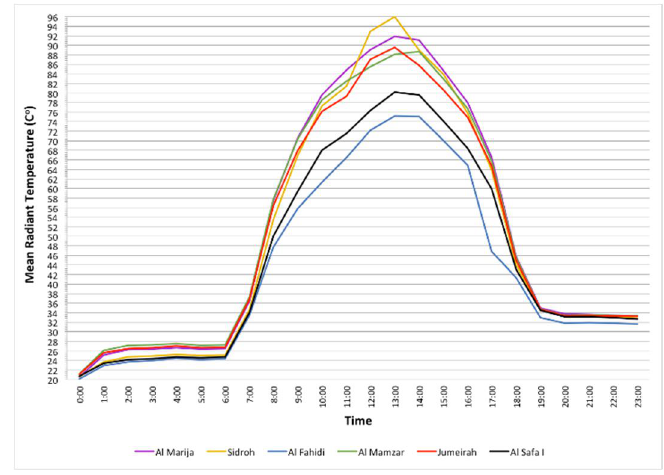
Figure 21. Average mean radiant temperature (°C) for Al Marija, Sidroh, Al Fahidi, Al Mamzar, Jumeirah, and Alsafa I in August.